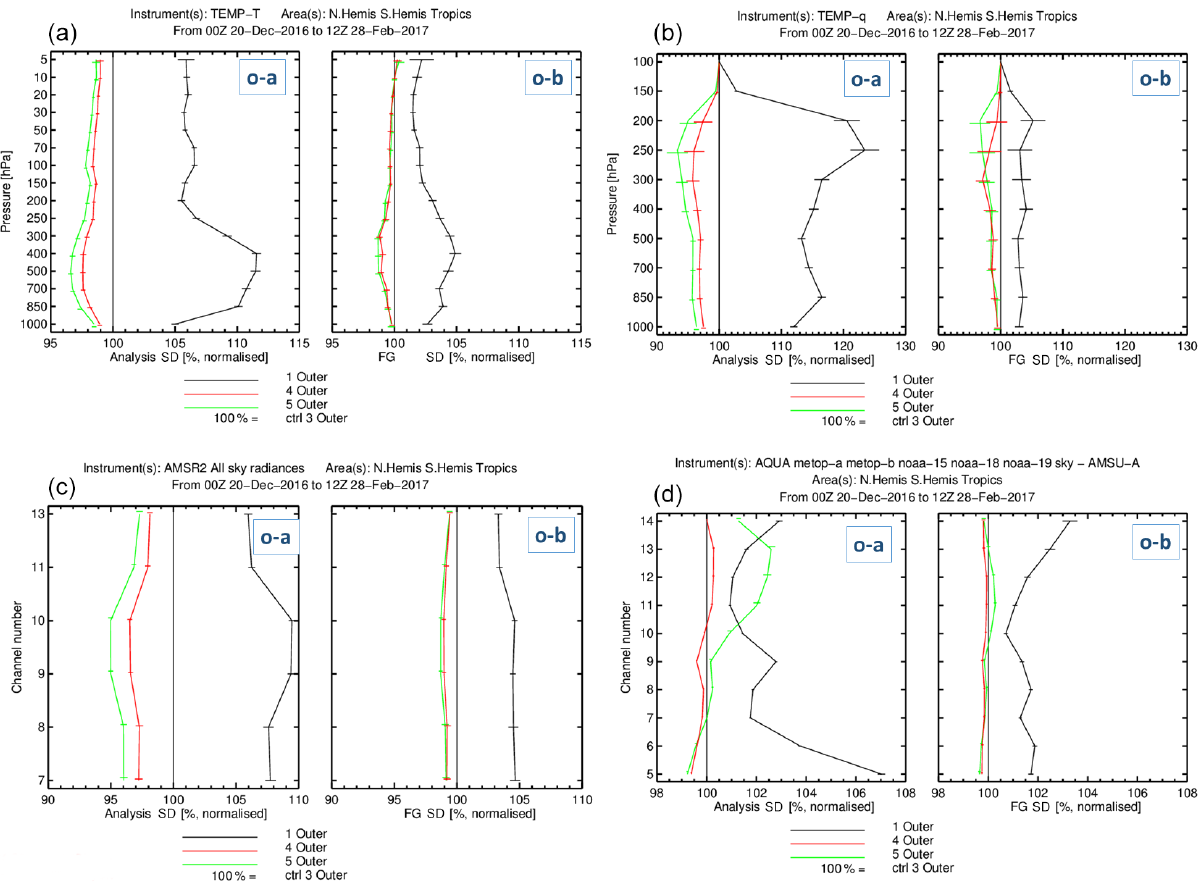
Figure 11. Normalised standard deviations of analysis (o − a) and first guess (o − b) departures for radiosonde temperature observations (a) ; radiosonde humidity observations (b) ; the microwave imager AMSR-2 (c) ; the combined observations from the AMSU-A microwave sounder instrument onboard the AQUA, METOP-A/B, and NOAA-15/18/19 satellites (d) . The 100% baseline refers to the three outer loop ex- periment, the black/red/green lines to the one/four/five outer loop experiments, respectively. Values smaller/larger than 100 indicated a tighter/looser fit of the analysis/first guess to the observations relative to the three outer loop baseline experiment. Values are averaged over the 20 December 2016 to 28 February 2017 period. Error bars represent 95% confidence